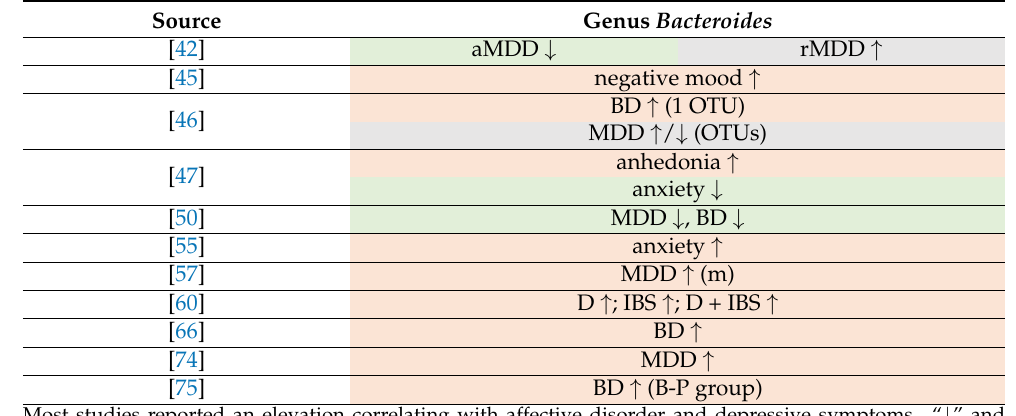
Table 3. Different abundance of genus